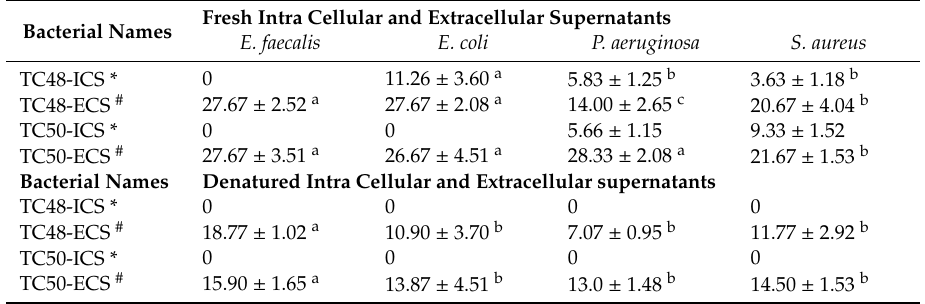
Table 6. Antibacterial activities of fresh and denatured ICS and ECS of TC48 and TC50 against pathogenic bacteria—well di ff usion method.